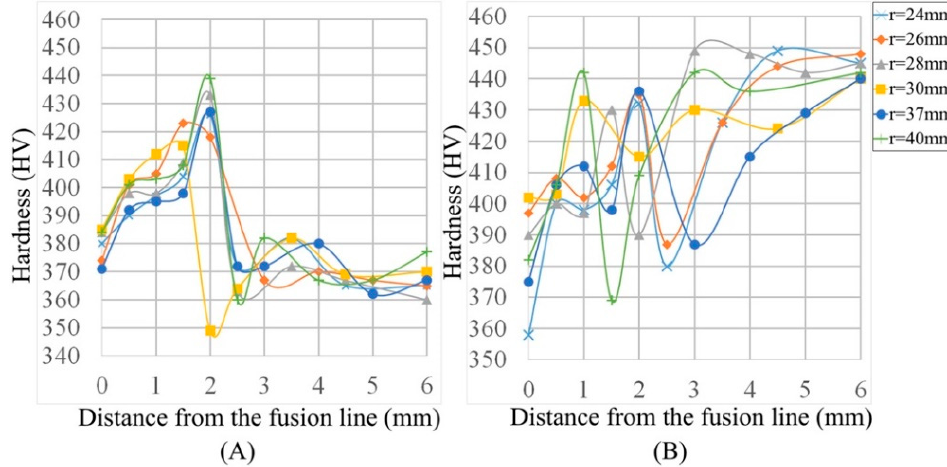
Figure 8. Microhardness variation in HAZ sub-zones of S1100 ( A ) virgin and ( B ) cold-formed sides Reprinted with permission from ref. [105]. Copyright 2019, Elsevier.